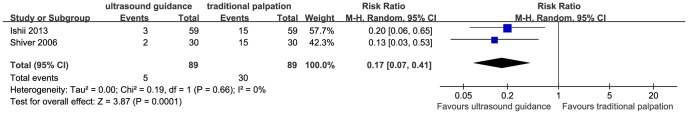
The forest plot depicting the occurrence of hematoma.